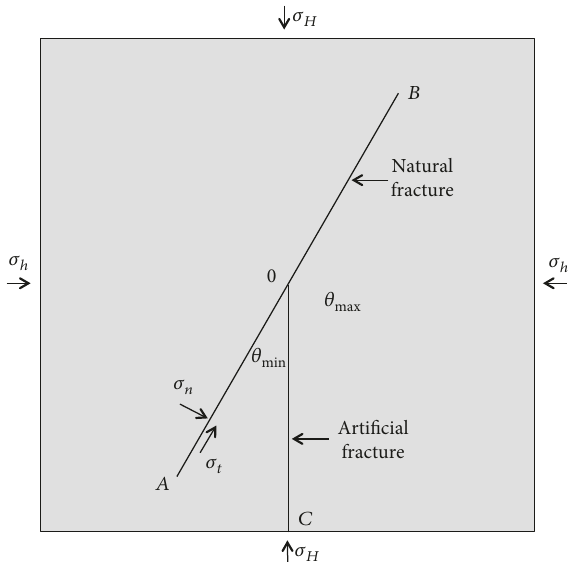
Figure 6: Additional resistance e ff ect of a small